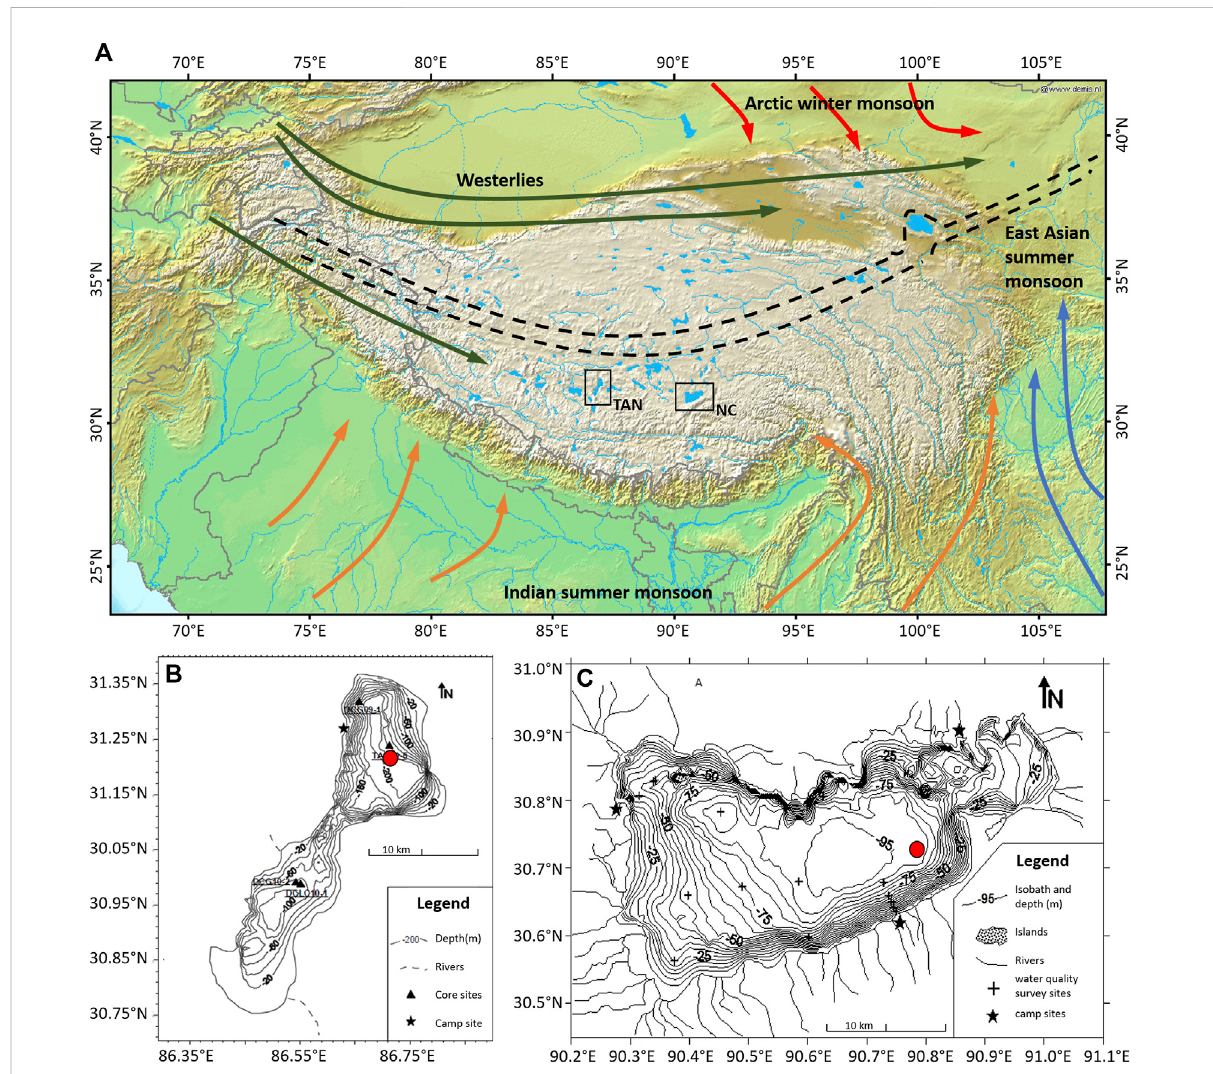
FIGURE 1 (A) Topographic map of the Tibetan Plateau showing the locations of Nam Co (NC) and Tangra Yumco (TAN) (map source: http://www.demis. nl) and the atmospheric system, including the Indian summer monsoon (ISM) in orange, the East Asian summer monsoon (EASM) in blue, and the Westerlies in green, as well as the Asian winter monsoon (AWM) in red (Anslan et al., 2020). The dotted black lines denote the summer monsoon transition zone(SMTZ) as suggested by Wünnemannetal. (2018). (B) Bathymetric map ofTangraYumcowith core siteTAN12-2 (reddot, Wang et al., 2010), and (C) bathymetric map of Nam Co with core site NC08/01 (red dot, Wang et al.,